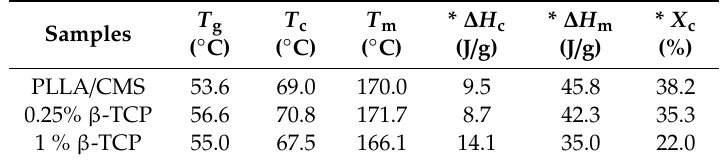
Table 1. Data from the DSC curves for the changes in the β -TCP content in the composite nanofibers. T Samples